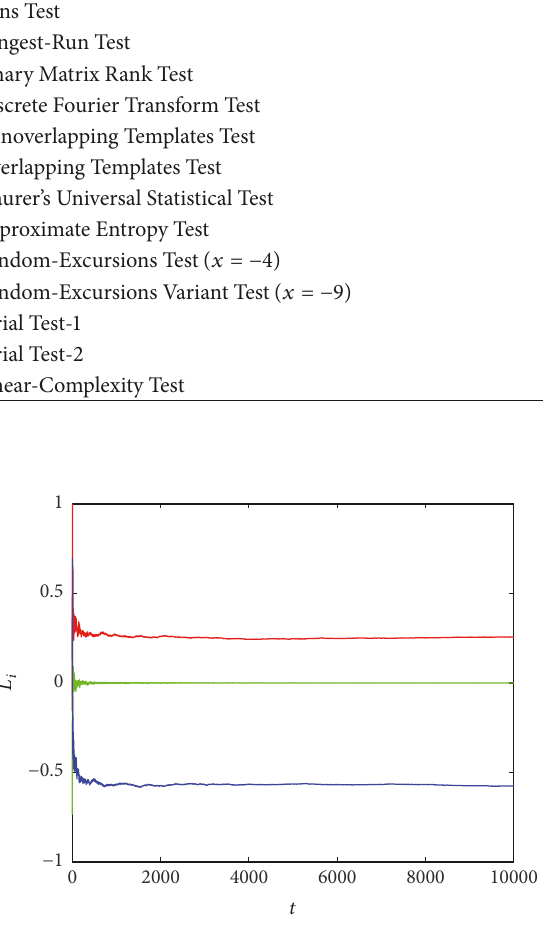
Figure 2: Lyapunov exponents of system without equilibrium (8) for 𝑎 = 2 , 𝑏 = 0.1 , 𝑐 = 2.5 , and 𝑑 = 0.3 and initial conditions (𝑥(0),𝑦(0),𝑧(0)) = (1, 1, 1) : 𝐿 Positive value of Lyapunov exponent 𝐿 1 indicates chaos of system (8).